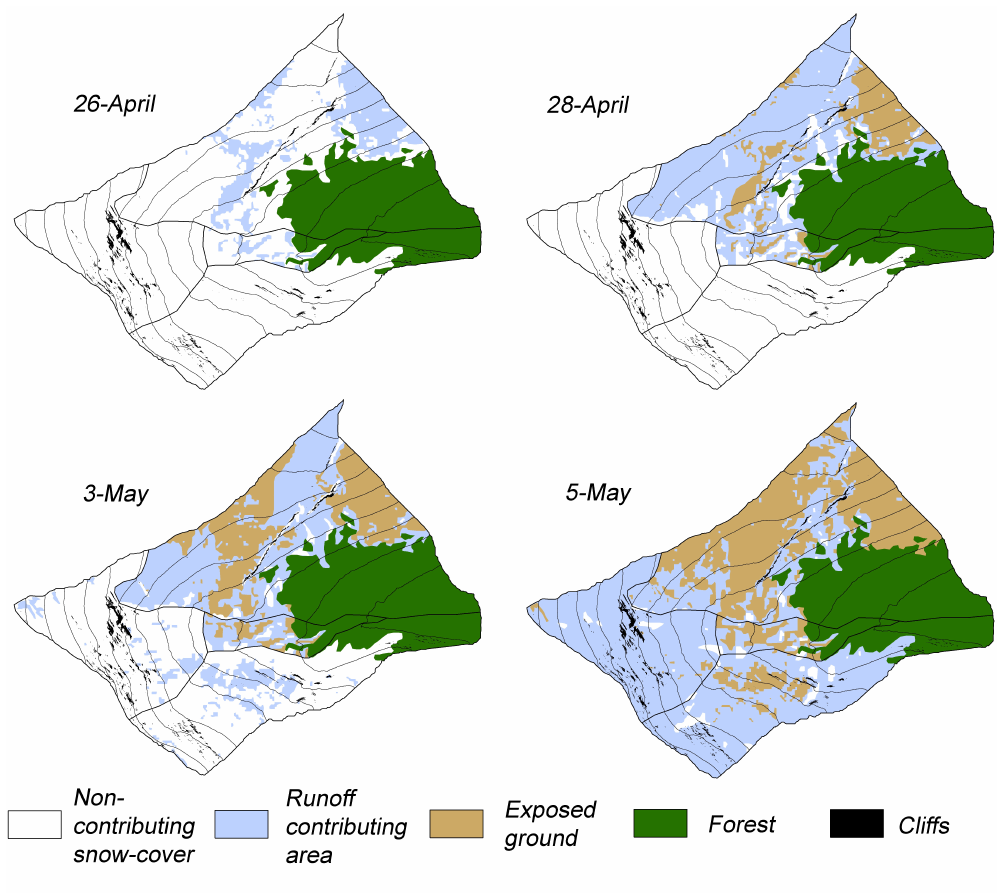
Fig. 8. Spatial snowcover and SRCA patterns over the Upper Middle Creek Basin (showing the four different slope-based HRUs) in the early snowmelt period of 2008. Patterns were mapped based on the spatial distribution of snow depth and SWE derived from the repeat LiDAR data. Snow melt patterns were not simulated in the densely forested or cliff